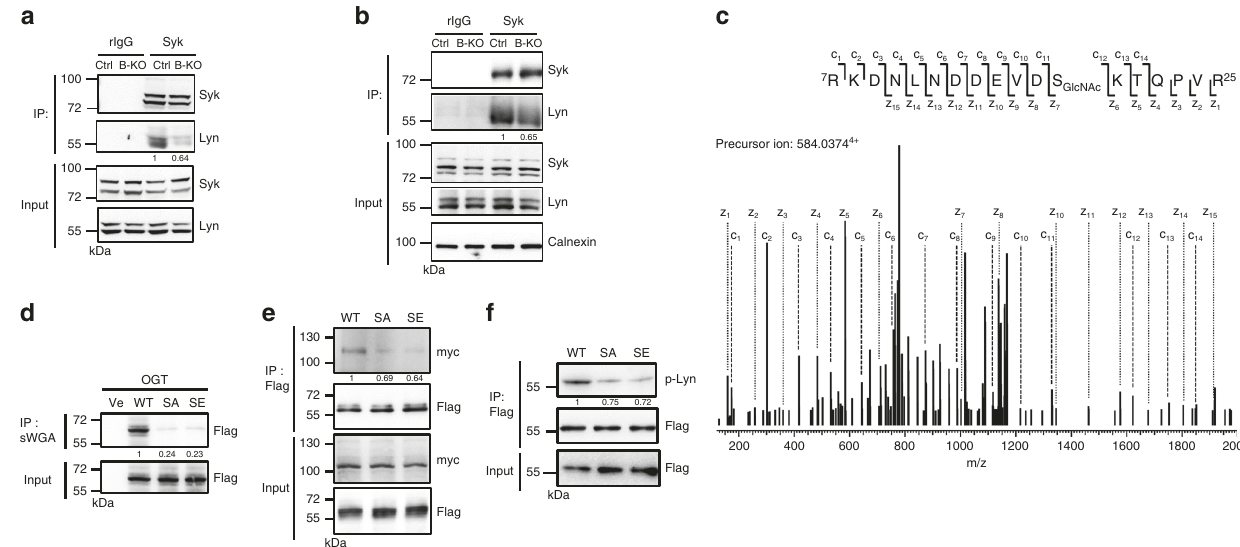
Fig. 4 O -GlcNAcylation of Lyn at S19 is required for the interaction of Syk. a Lysates prepared from Ctrl and B-KO splenic B cells stimulated with anti-IgM for 5 min were subjected to immunoprecipitation (IP) with anti-Syk or control rabbit IgG (rIgG) antibody, followed by immunoblotting (IB) with the indicated antibodies. b Protein lysates from membrane fractions of anti-IgM stimulated Ctrl and B-KO splenic B cells were subjected to IP with anti-Syk or rIgG antibody, followed by IB with indicated antibodies. Calnexin served as a loading control for membrane fraction. c Mapping the O -GlcNAc site on S19 of mouse Lyn by using ETD fragmentation. The ions, z 6 + ( m/z 712.4188), z 7 + ( m/z 1002.5387), c 11 + ( m/z 1331.6101), and c 12 + ( m/z 1622.7351) indicated that S19 carried a GlcNAc moiety. d Lysates from 293 T cells overexpressing the vector control (Ve), Flag-EGFP-tagged WT, SA or SE Lyn were subjected to a pull-down assay using sWGA agarose beads, followed by IB with an anti-Flag antibody. e Lysates from 293T cells transfected with Flag-tagged WT, SA, or SE Lyn along with myc-tagged Syk were subjected to IP with anti-Flag antibody, followed by IB with the indicated antibodies. f Anti-Flag immunoprecipitates from Ramos B cells transfected with vector expressing Flag-EGFP-WT, -SA or -SE Lyn and stimulated with anti-IgM (25 µ g ml − 1 ) for 5 min were subjected to IB with indicated antibodies. In a , b , d , e and f , the representative data from one of at least 2 – 3 experimental repeats are shown. Quanti fi cation of band intensity is indicated in a , b , d , e and